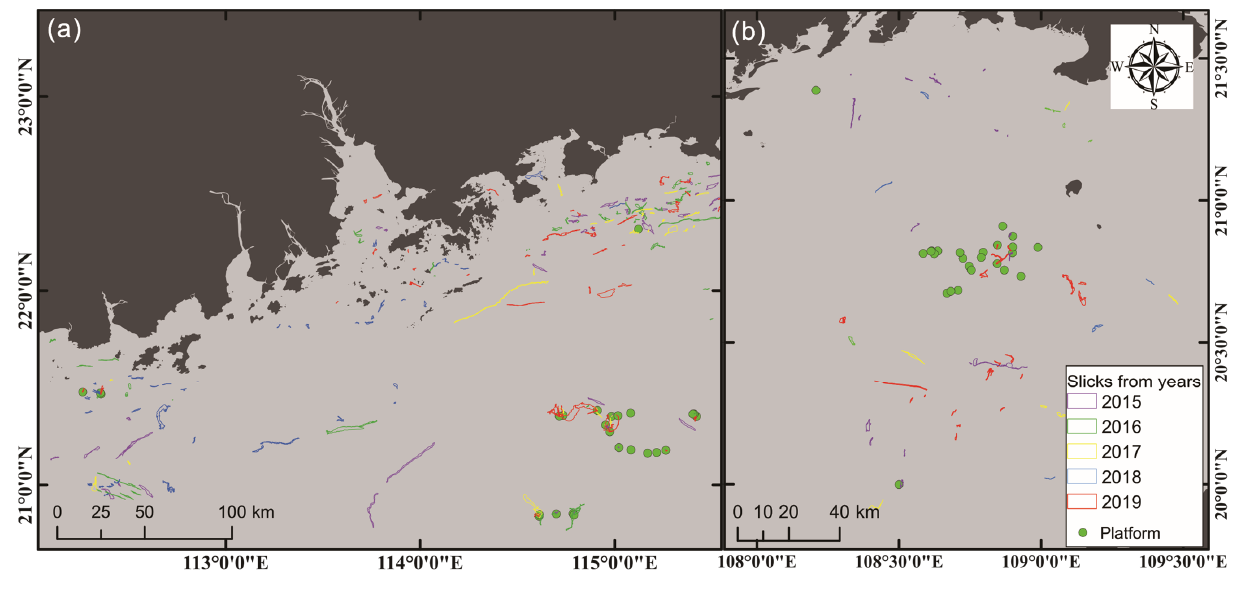
Figure 11. Distribution of oil slicks in: ( a ) the Guangdong–Hong Kong–Macao Greater Bay Area; and ( b ) northeastern Beibu Gulf. Black points denote oil platforms location. Table 2. Statistical data for delineated oil slicks in the Guangdong–Hong Kong–Macao Greater Bay